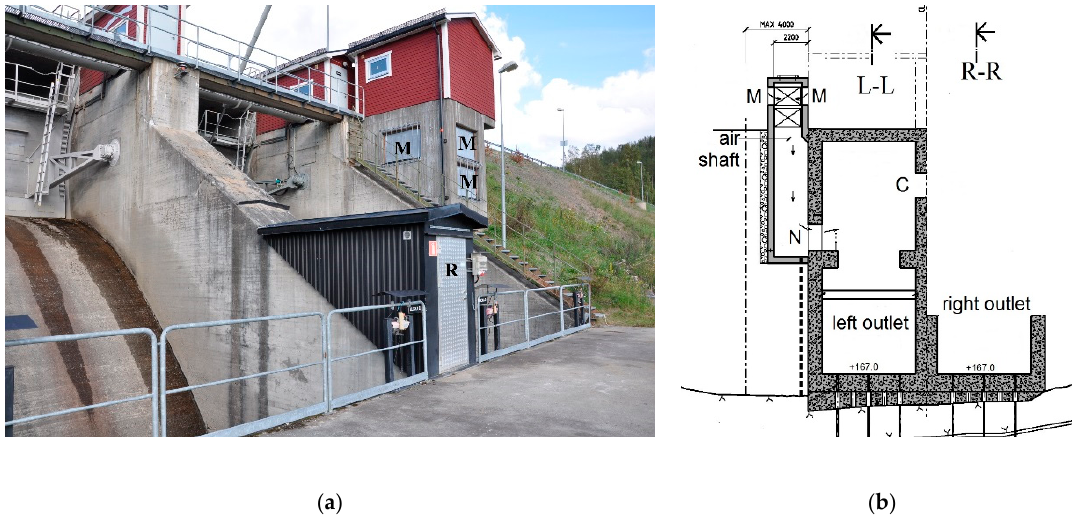
Figure 2. Spillway Layout with two air passages: ( a ) downstream view; ( b ) cross-section along dam axis.